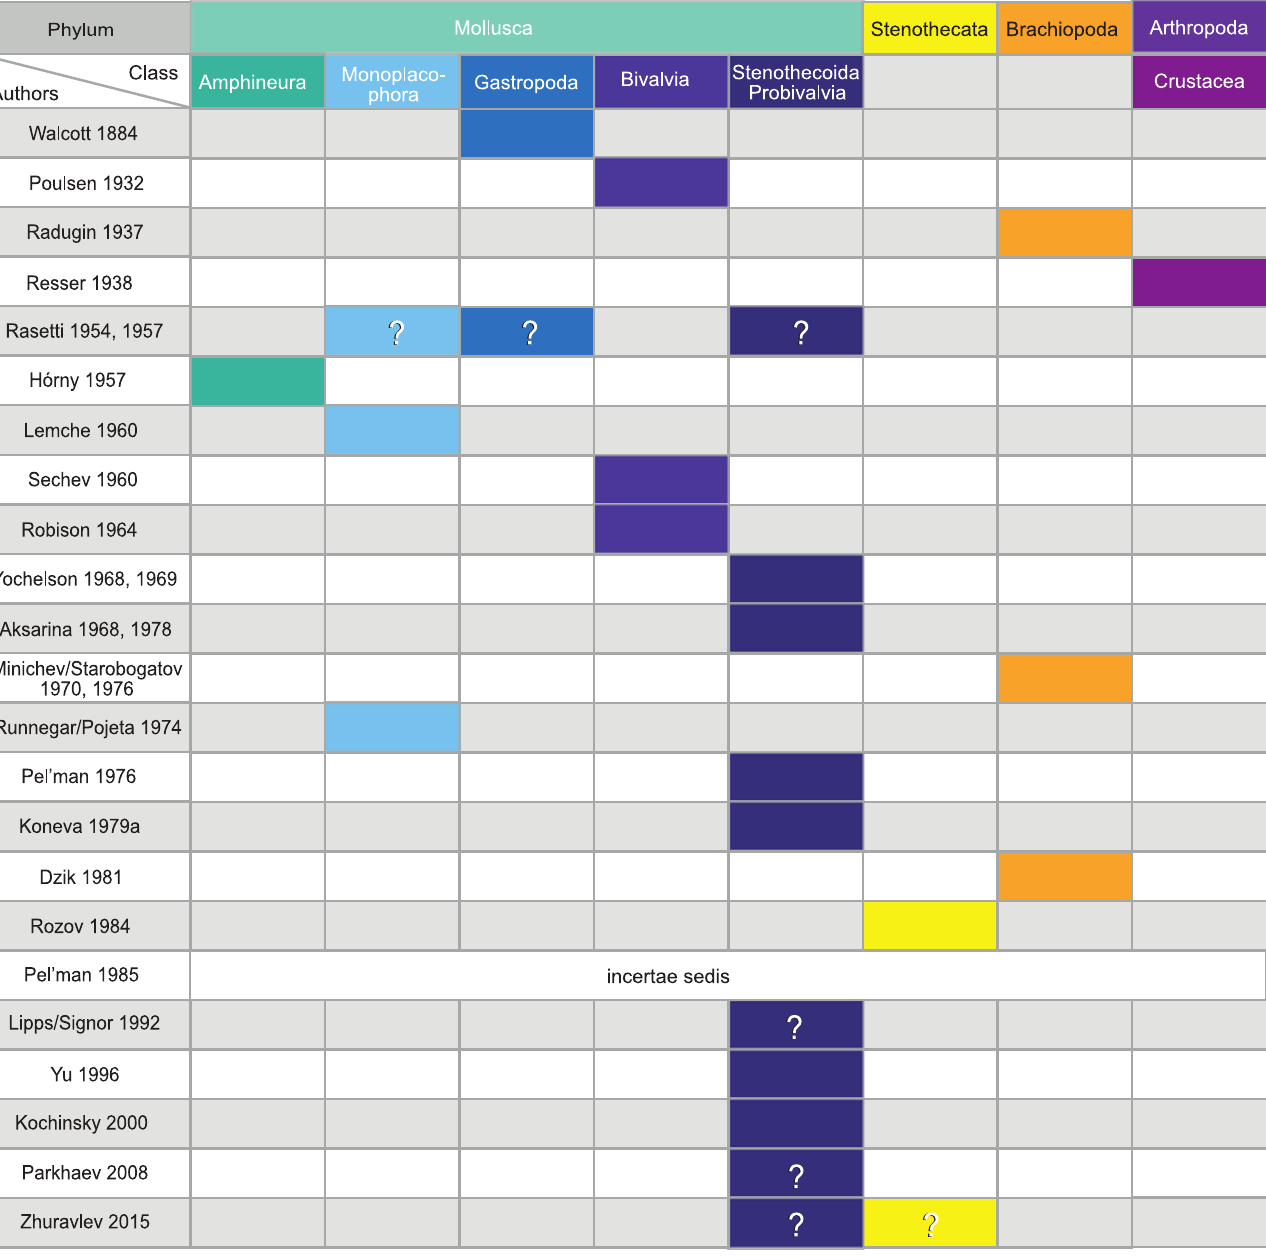
Fig. 1. Historical interpretations of the systematic position of stenothecoids (updated from Pel’man